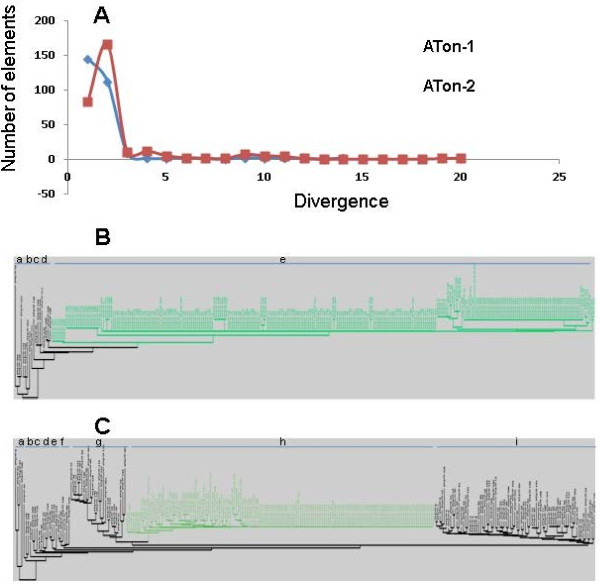
 Amplification of ATon-I and ATon-II families. (A) Divergence distribution of ATons. x-axis, divergence of an ATon member from its consensus sequence; y-axis, number of ATon elements. (B) Phylogenetic tree of ATon-I family. Letters “a” to “e”, five subclades. (C) Phylogenetic tree of ATon-2 family. Letters “a” to “i”, nine subclades. Green highlights, subclades with large numbers of identical elements.